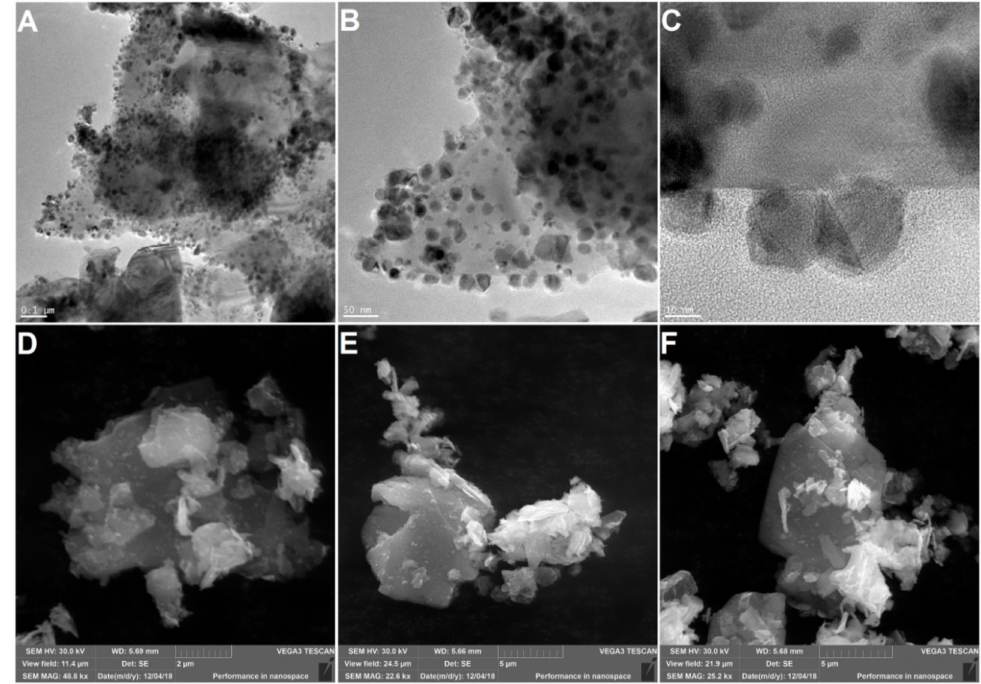
Figure 4. TEM ( A–C ) and SEM ( D – F ) images of MoS 2 / Ni 2 O 3 / DOPO